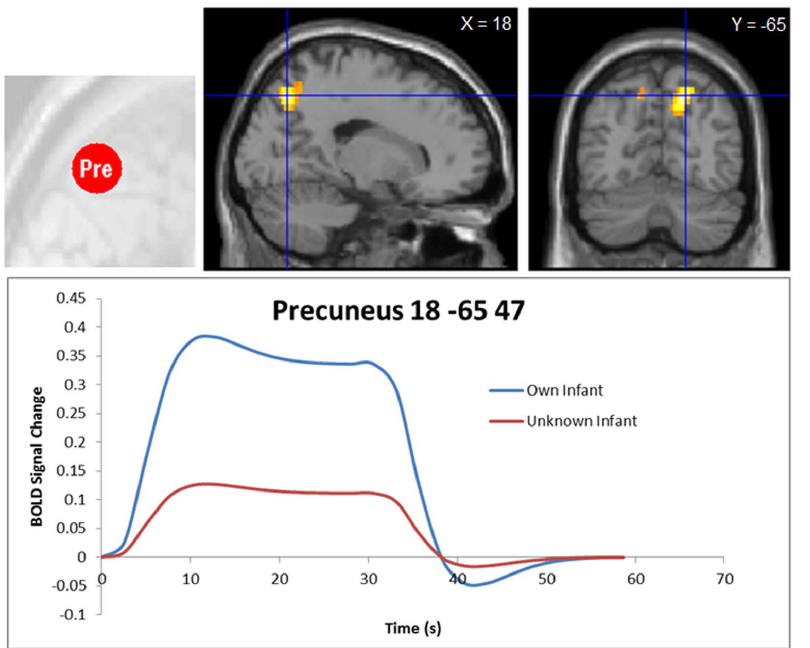
Figure 2. Time course of the group mean BOLD response in the precuneus (18, 2 65, 47) for viewing video of own infant and unknown infant for 30 secs.